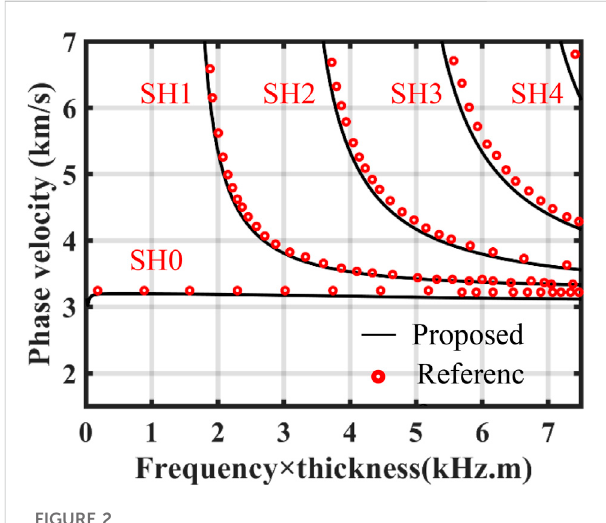
FIGURE 2 Dispersion curves of circumferential SH waves in cementing